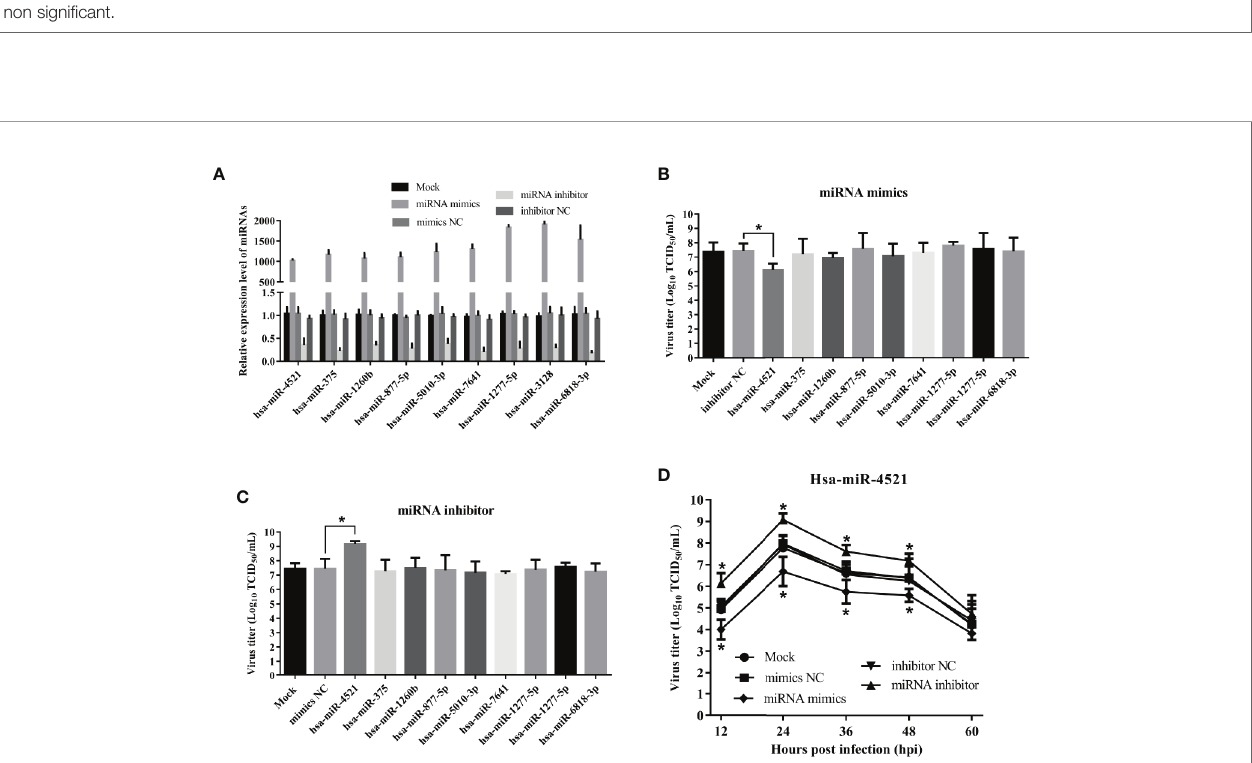
FIGURE 7 | The effect of 9 veri fi ed SDE miRNAs on NDV replication in HeLa cells. (A) HeLa cells were transfected with indicated miRNA oligonucleotides ( fi nal concentration, 100 nM) and the expression levels of corresponding miRNAs were measured by qRT-PCR assay at 18h after transfection. (B, C) HeLa cells transfected with corresponding miRNA mimics (B) or miRNA inhibitor (C) were infected with Herts/33 at an MOI of 1. After 24h, viral titers in cellular supernatants were measured by TCID 50 as described above. (D) HeLa cells were transfected with indicated miRNA oligonucleotides at a fi nal concentration of 100 nM or left untreated. Eighteen hours after transfection, HeLa cells were infected with Herts/33 at an MOI of 0.1. The viral road in the supernatants collected at different time points was quanti fi ed by TCID 50 in DF-1 cells. Data are from three independent experiments and presented as the means ± SD. * stands for P -value < 0.05.